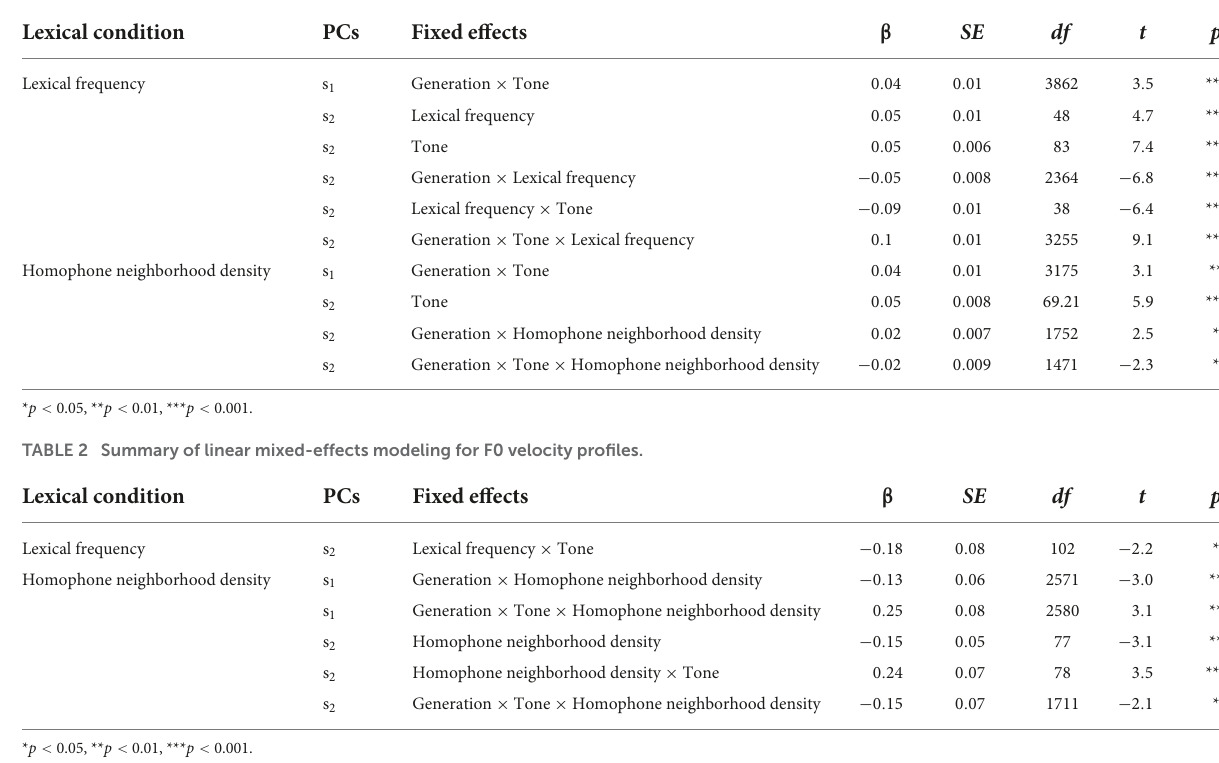
TABLE 3 Summary of linear mixed-effects modeling for F0 curves (from subset data of generation, tone, and lexical conditions). Generation